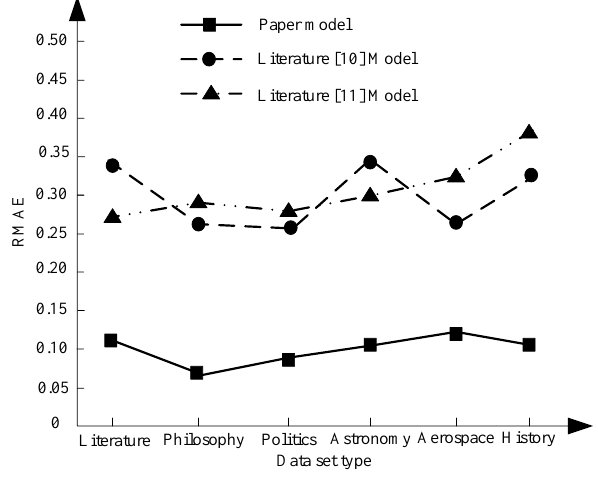
Fig. 3. Comparison of average absolute error of resource matching